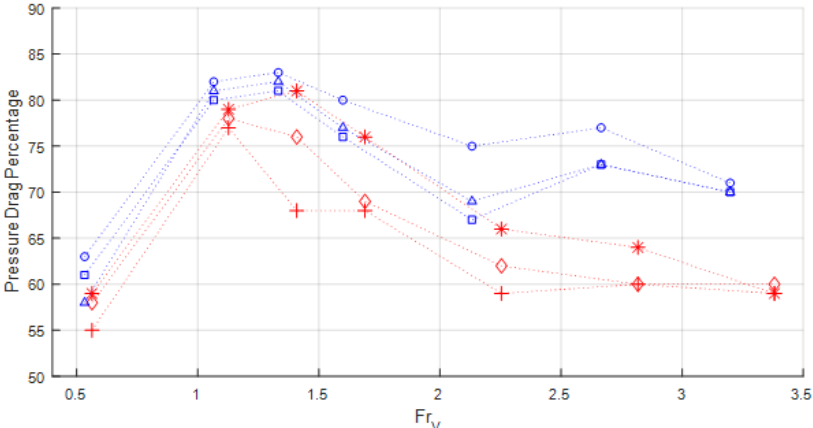
Figure 14. Comparison of the pressure drag expressed as the percentage of total drag for hulls with LCG = 45%. Circles and stars, constant-deadrise hull; squares and crosses, concave hull; triangles and diamonds, convex hull. Red larger symbols, nominal-weight condition ( C B = 0.912); blue smaller symbols, overloaded ( C B = 1.276).